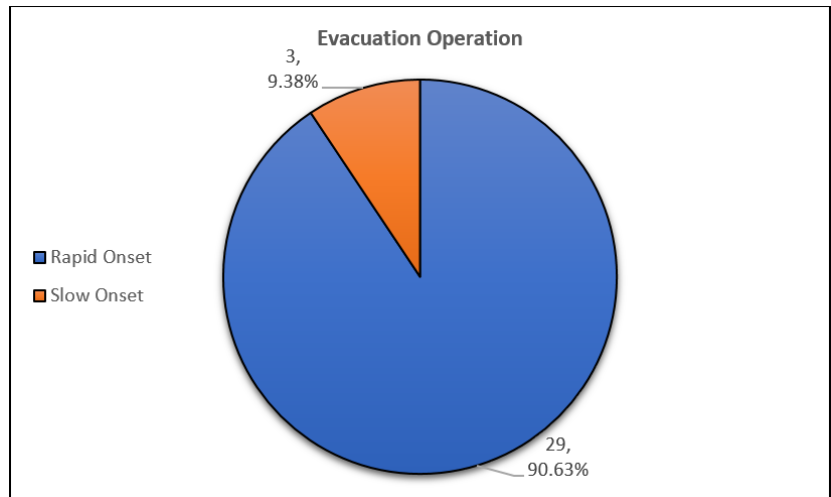
Figure 14. Breakdown of VRP Evacuation Operation based on Disaster